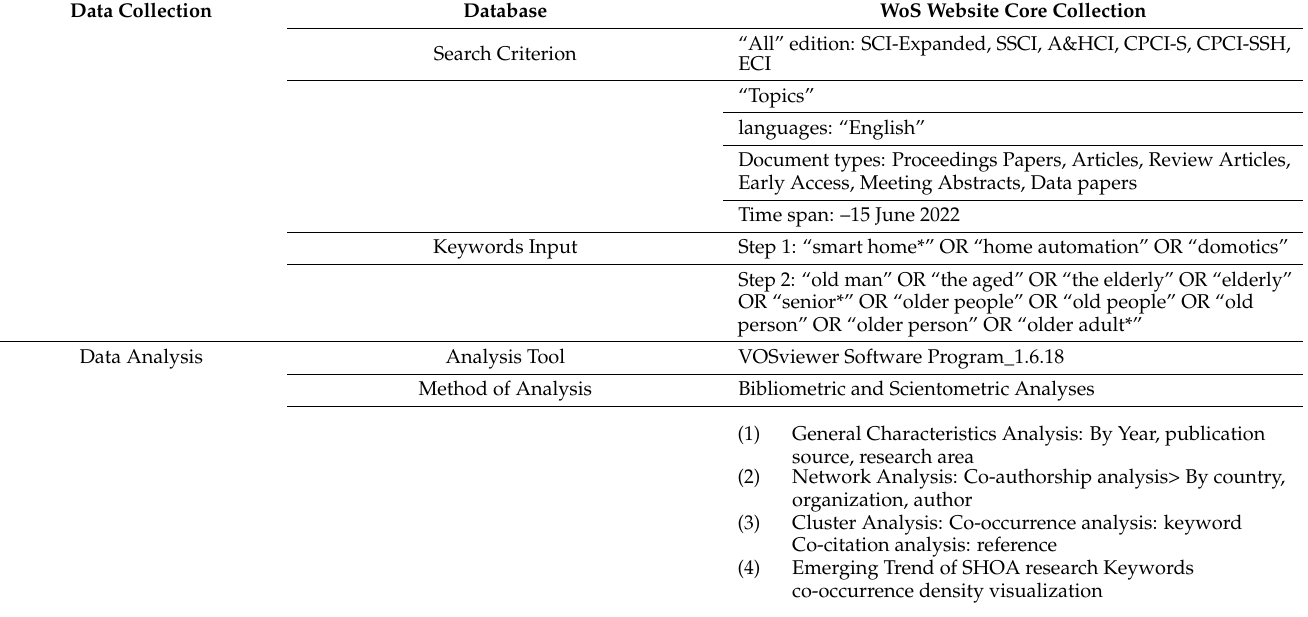
Table 1. Research method